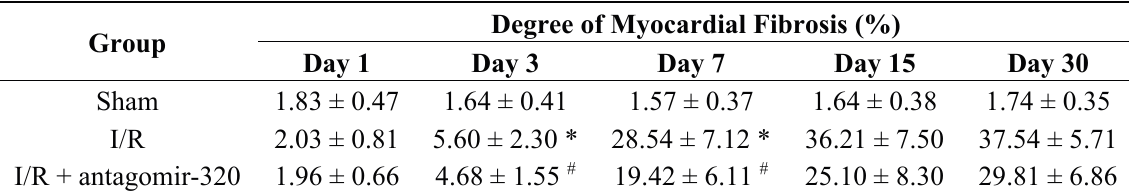
Table 2. Evaluation of the degree of myocardial fibrosis in three groups.